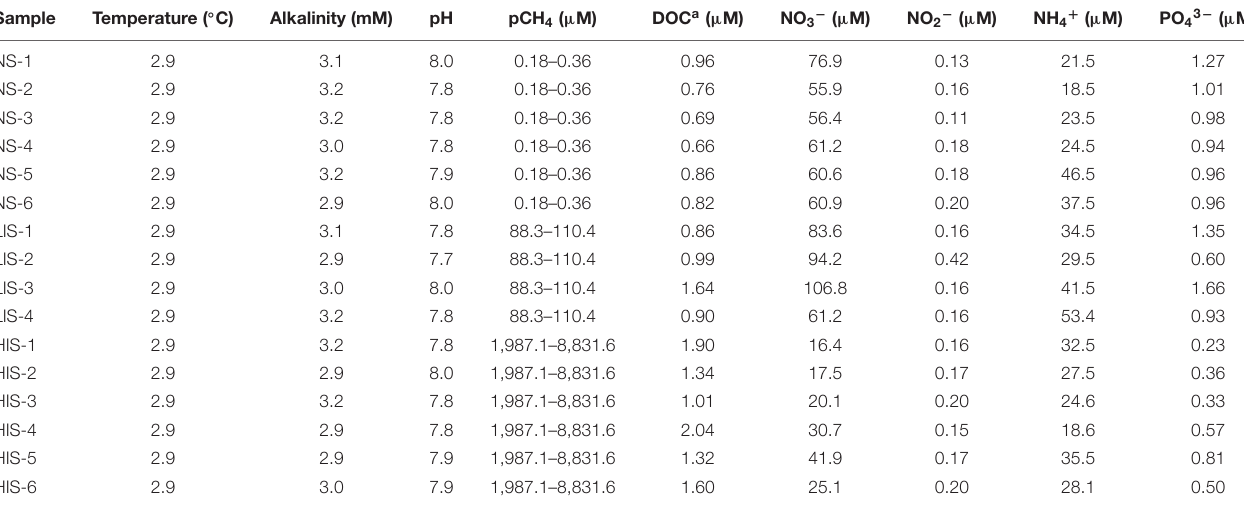
TABLE 1 | Profiles of environmental factors in the water columns of 16 samples of the study sites. Sample Temperature ( ◦